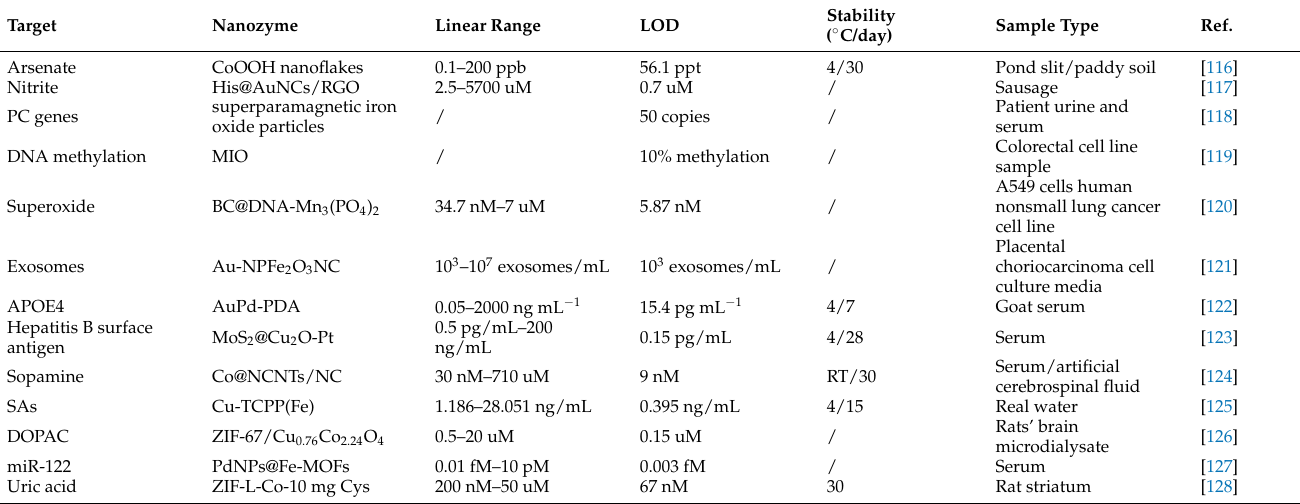
Table 5. Summary of the amperometric sensors detecting untraditional amperometry